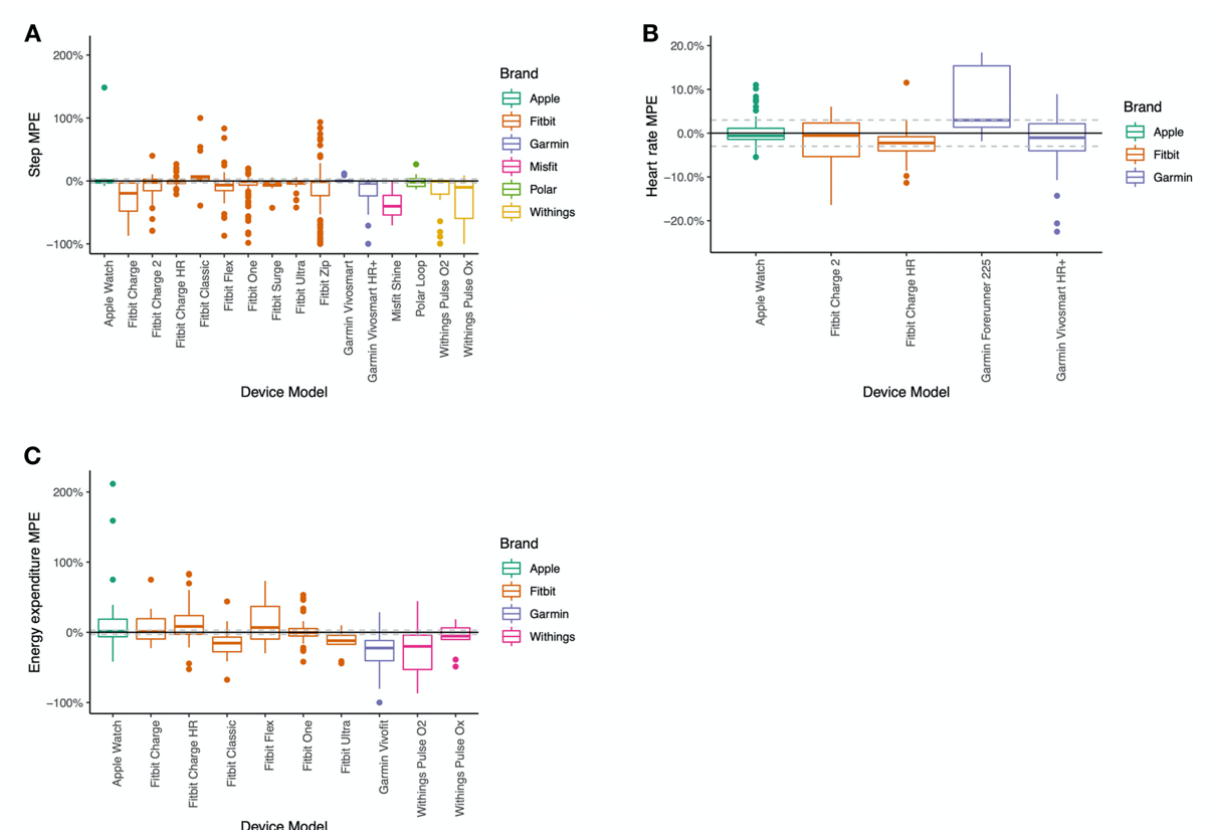
Figure 6. Box plots representing mean percentage error (MPE) for steps, heart rate, and energy expenditure by device brand and model for devices with 10 or more